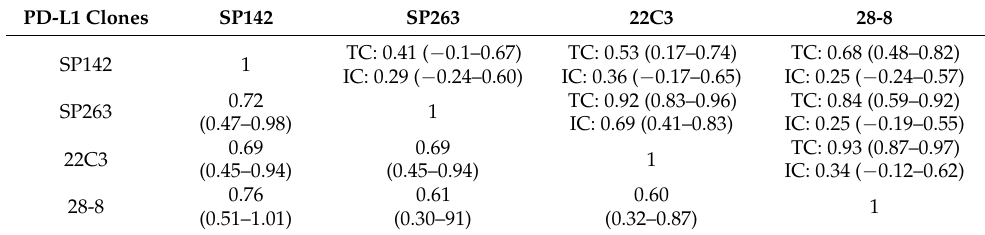
Table 2. Concordance of PD-L1 Expression Between PD-L1